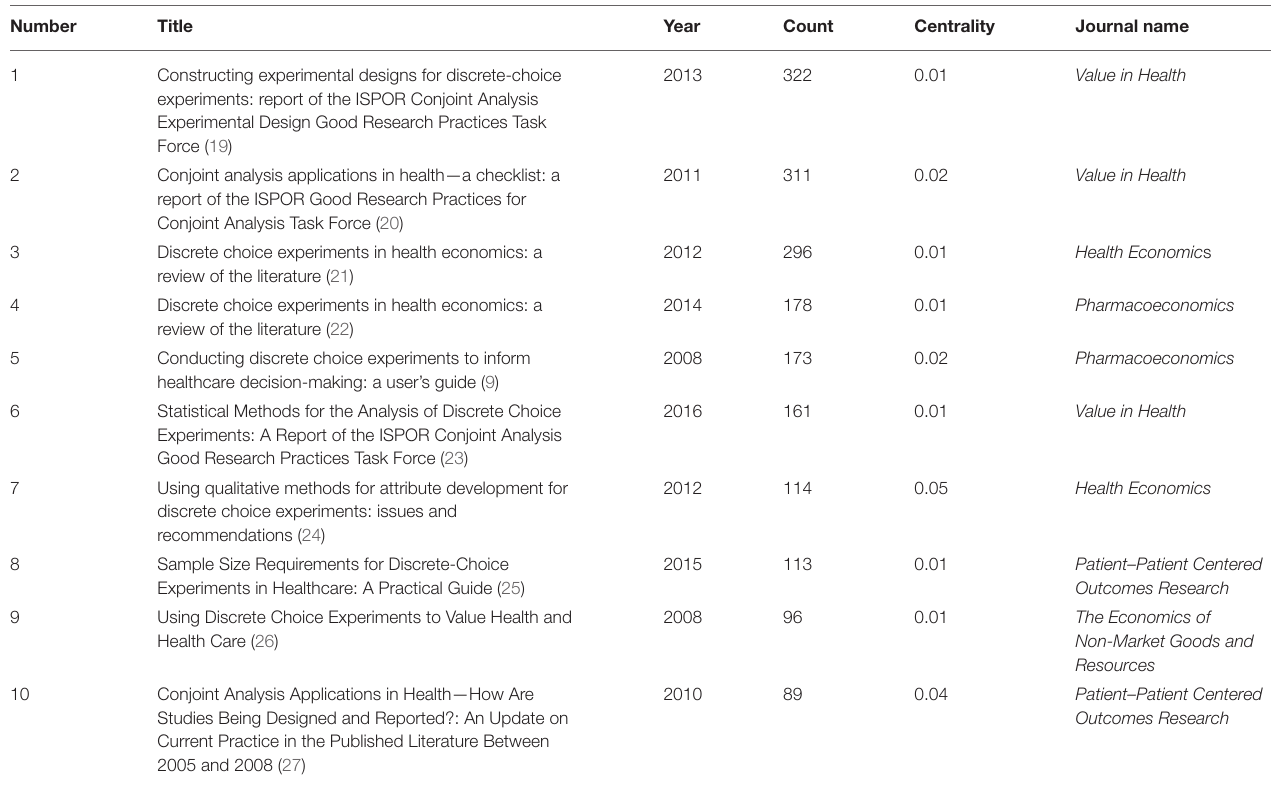
TABLE 4 | Top 10 cited references in discrete choice experiment (DCE) studies in health